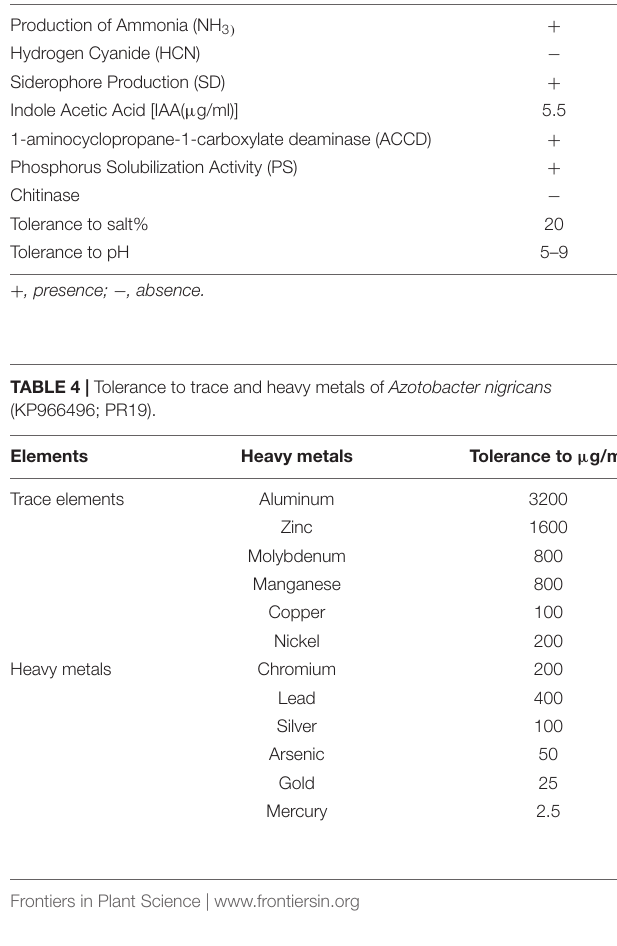
TABLE 3 | PGP traits of Azotobacter nigricans (KP966496; PR19). PGP